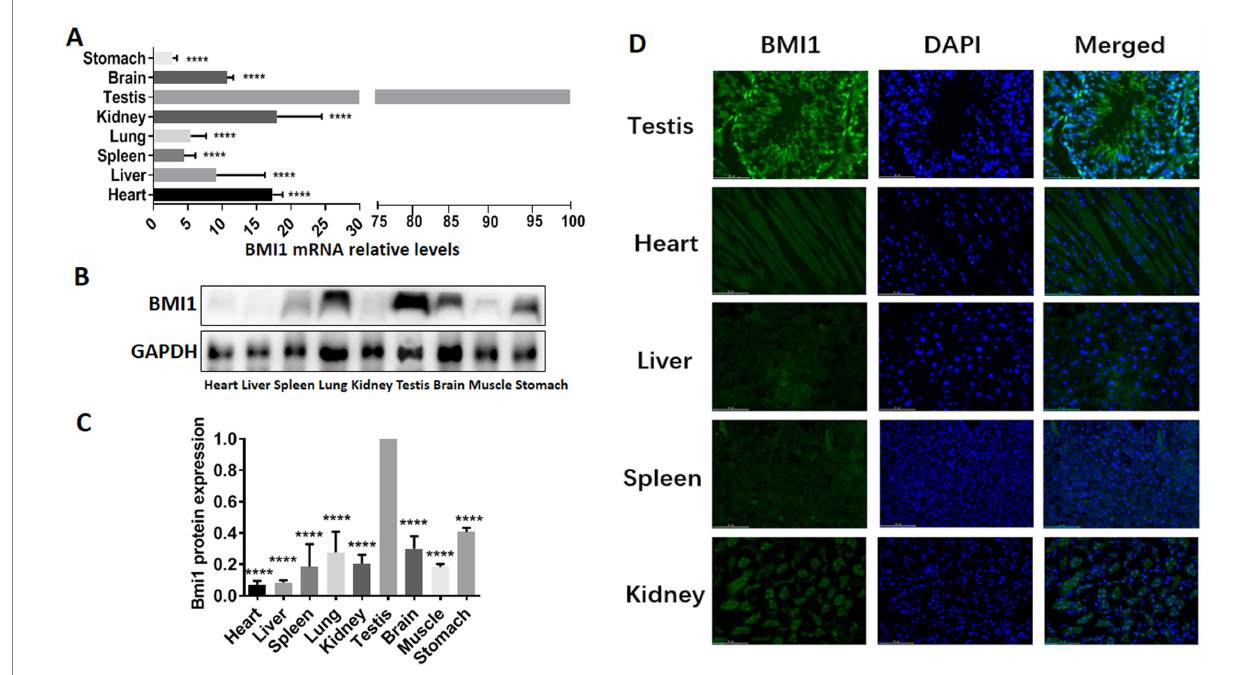
FIGURE 1 BMI1 was expressed at high levels in mouse testis and